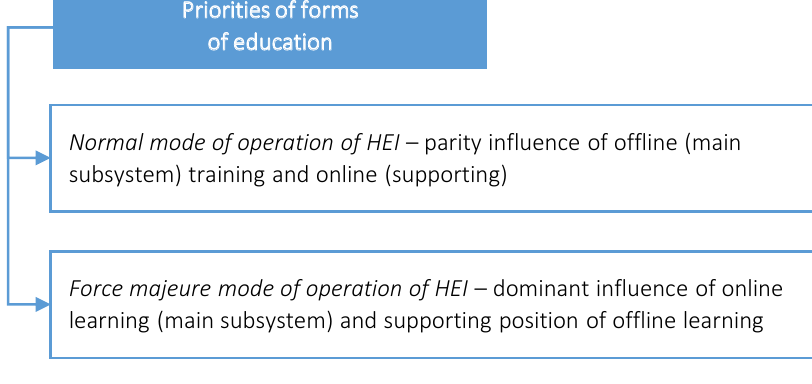
Figure 9. Directions of priority forms of education